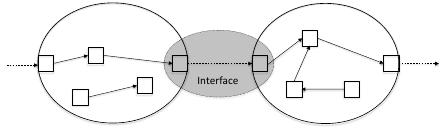
Figure 4: The basic structure of composed